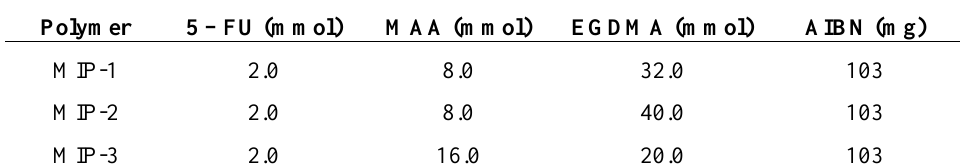
Table 1 . Polymer